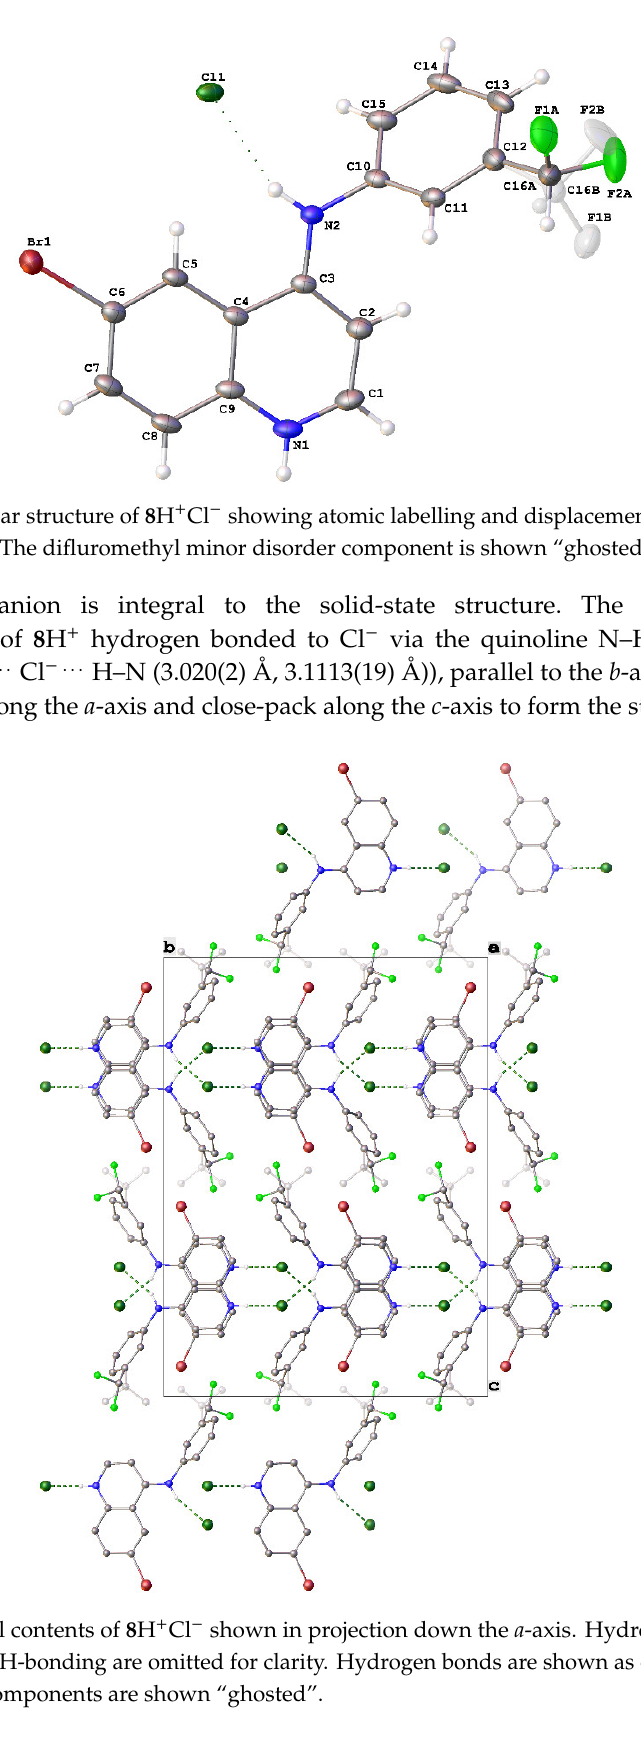
Figure 4. Unit cell contents of 8 H + Cl − shown in projection down the a -axis. Hydrogen atoms except those involved in H-bonding are omitted for clarity. Hydrogen bonds are shown as dashed green lines. Minor disorder components are shown “ghosted”.